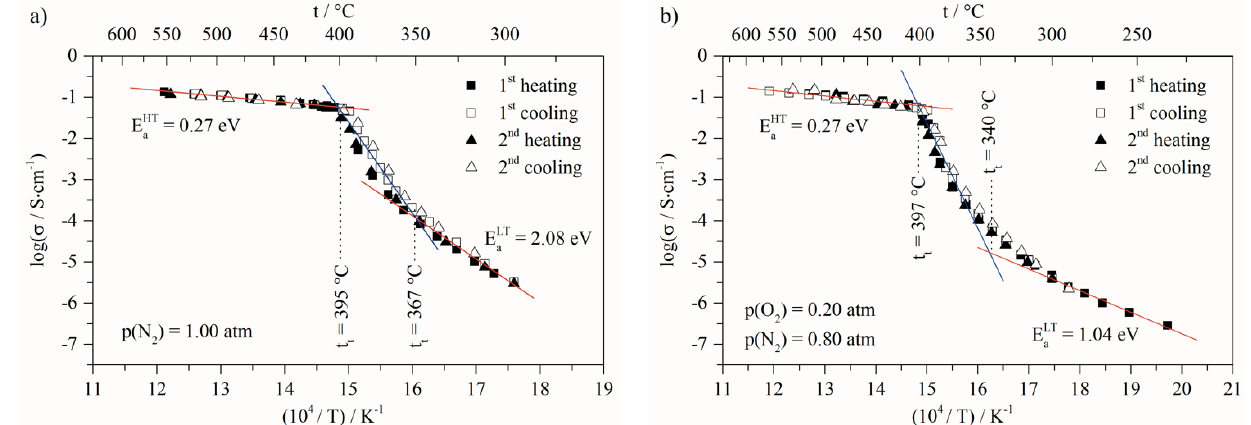
Figure 1. Arrhenius diagrams of the conductivity during two heating/cooling cycles for SDC—LiNaK composite electrolyte performed under pure nitrogen ( a ) and synthetic dry air ( b ) atmospheres. Activation energy values were obtained within low (E aLT ) and high (E aHT ) temperature regions of diagrams. Transition temperatures are defined by t t .